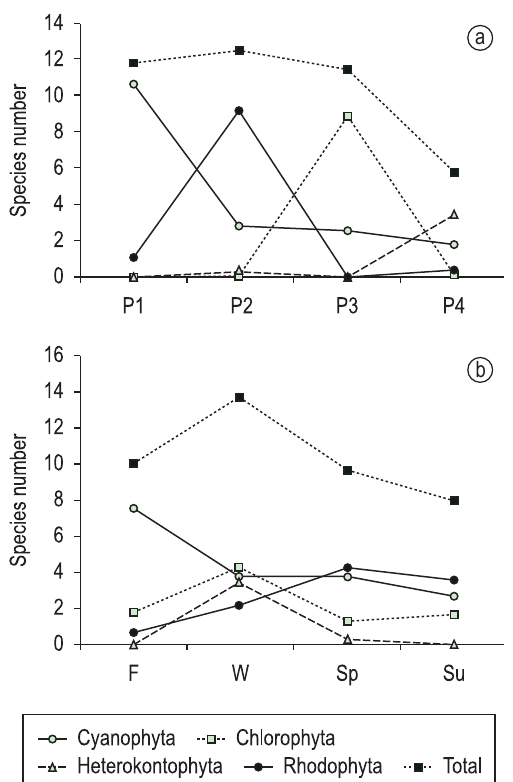
Figure 3. Macroalgal percent cover (a) in the sampling sites and (b) seasons in the Cascavel Stream, Guarapuava, Paraná State. F = Fall, W = Winter, Sp = Spring and, Su =